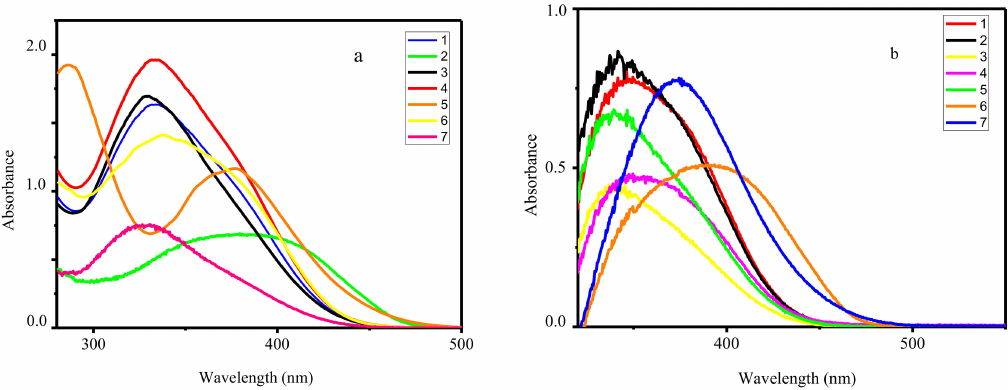
Figure 2. UV − vis absorption spectra of HL1–HL7 ( a ) and corresponding complexes 1–7 ( b ) in CH 3 CN at room temperature.